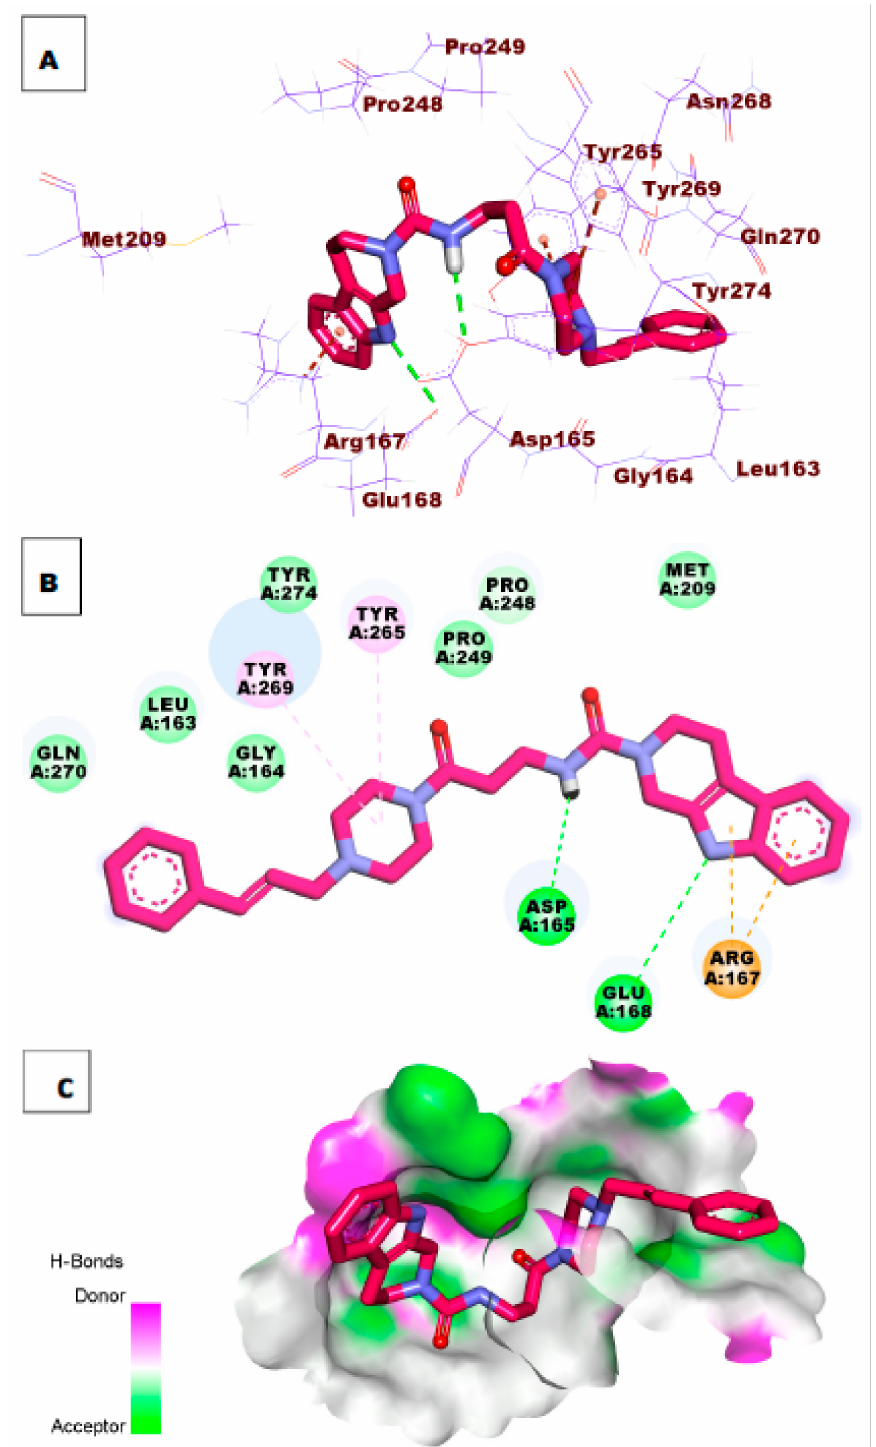
Figure 10. ( A ) 3D of compound 58 docked into the active site of PLpro. ( B ) 2D of compound 58 docked into the active site of PLpro. ( C ) Surface mapping of compound 58 docked into the active site of